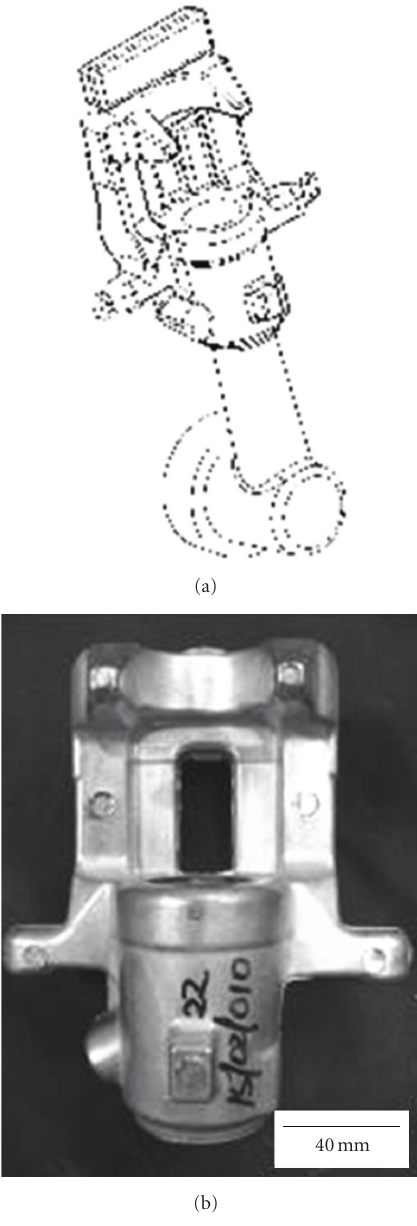
Figure 1: Example of the rheocast aluminum brake caliper including the runner and the biscuit in part drawing (a) and the actual premachined component